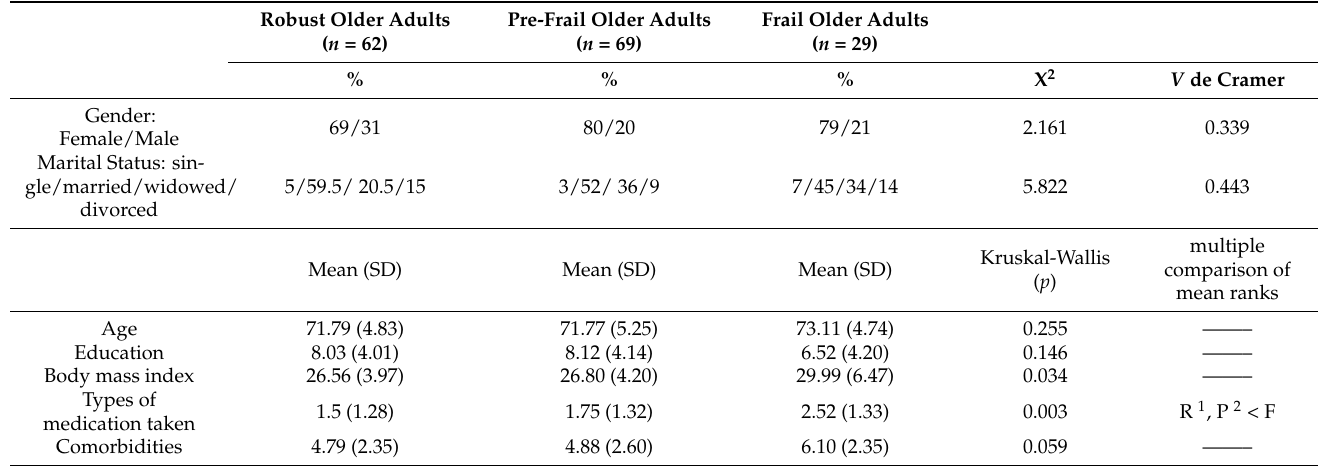
Table 1. Demographic, clinical, and neuropsychological characteristics of study participants.